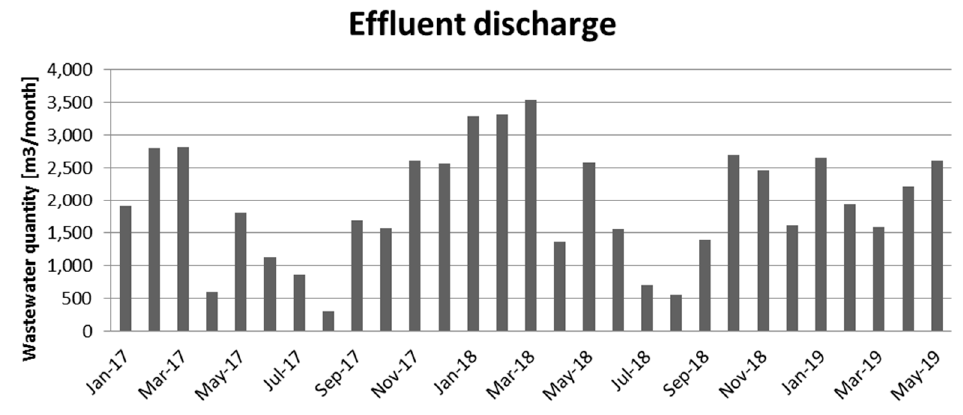
Figure 2. Monthly e ffl uent discharge from the CW of Cecchi winery, monitored from January 2017 to Figure 2. Monthly effluent discharge from the CW of Cecchi winery, monitored from January 2017 to May May 2019.